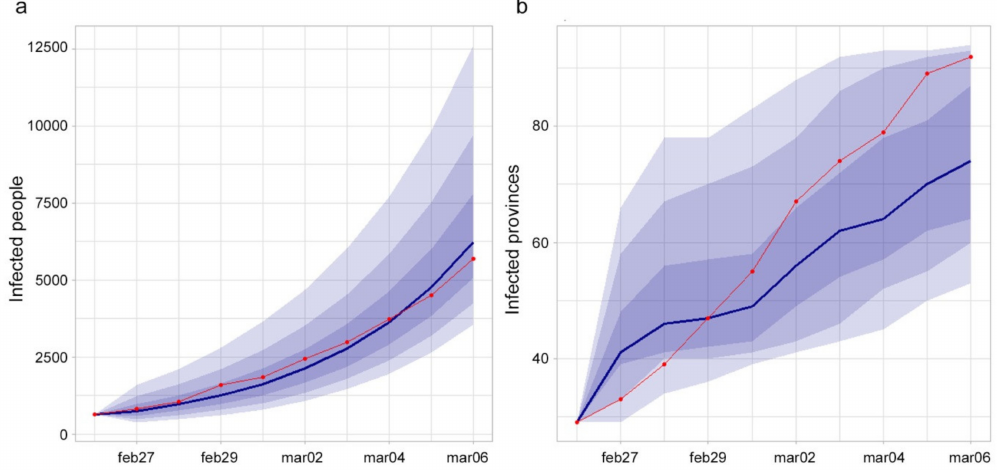
Figure 9. ( a ) Observed (red line) and estimated (blue line and 0.95, 0.80 and 0.50 CI) infected people in Italy. ( b ) Observed (red line) and estimated (blue line and 0.95, 0.80 and 0.50 CI) number of infected